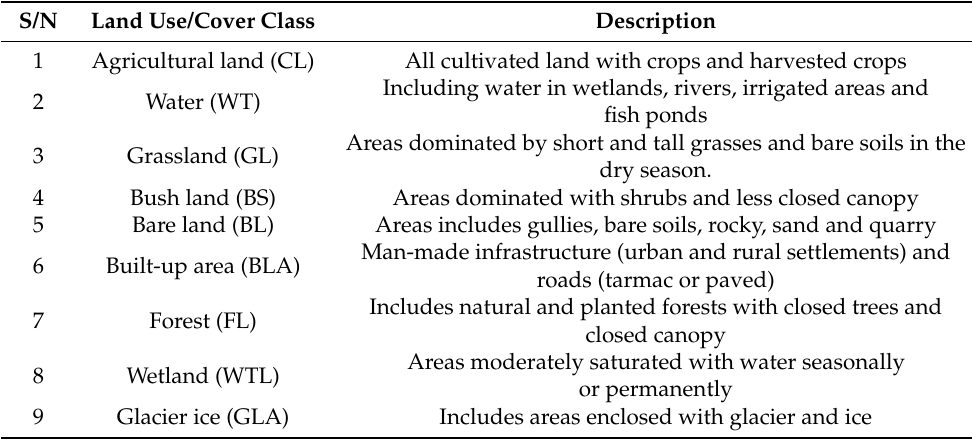
Table 1. Land use/cover classes and their